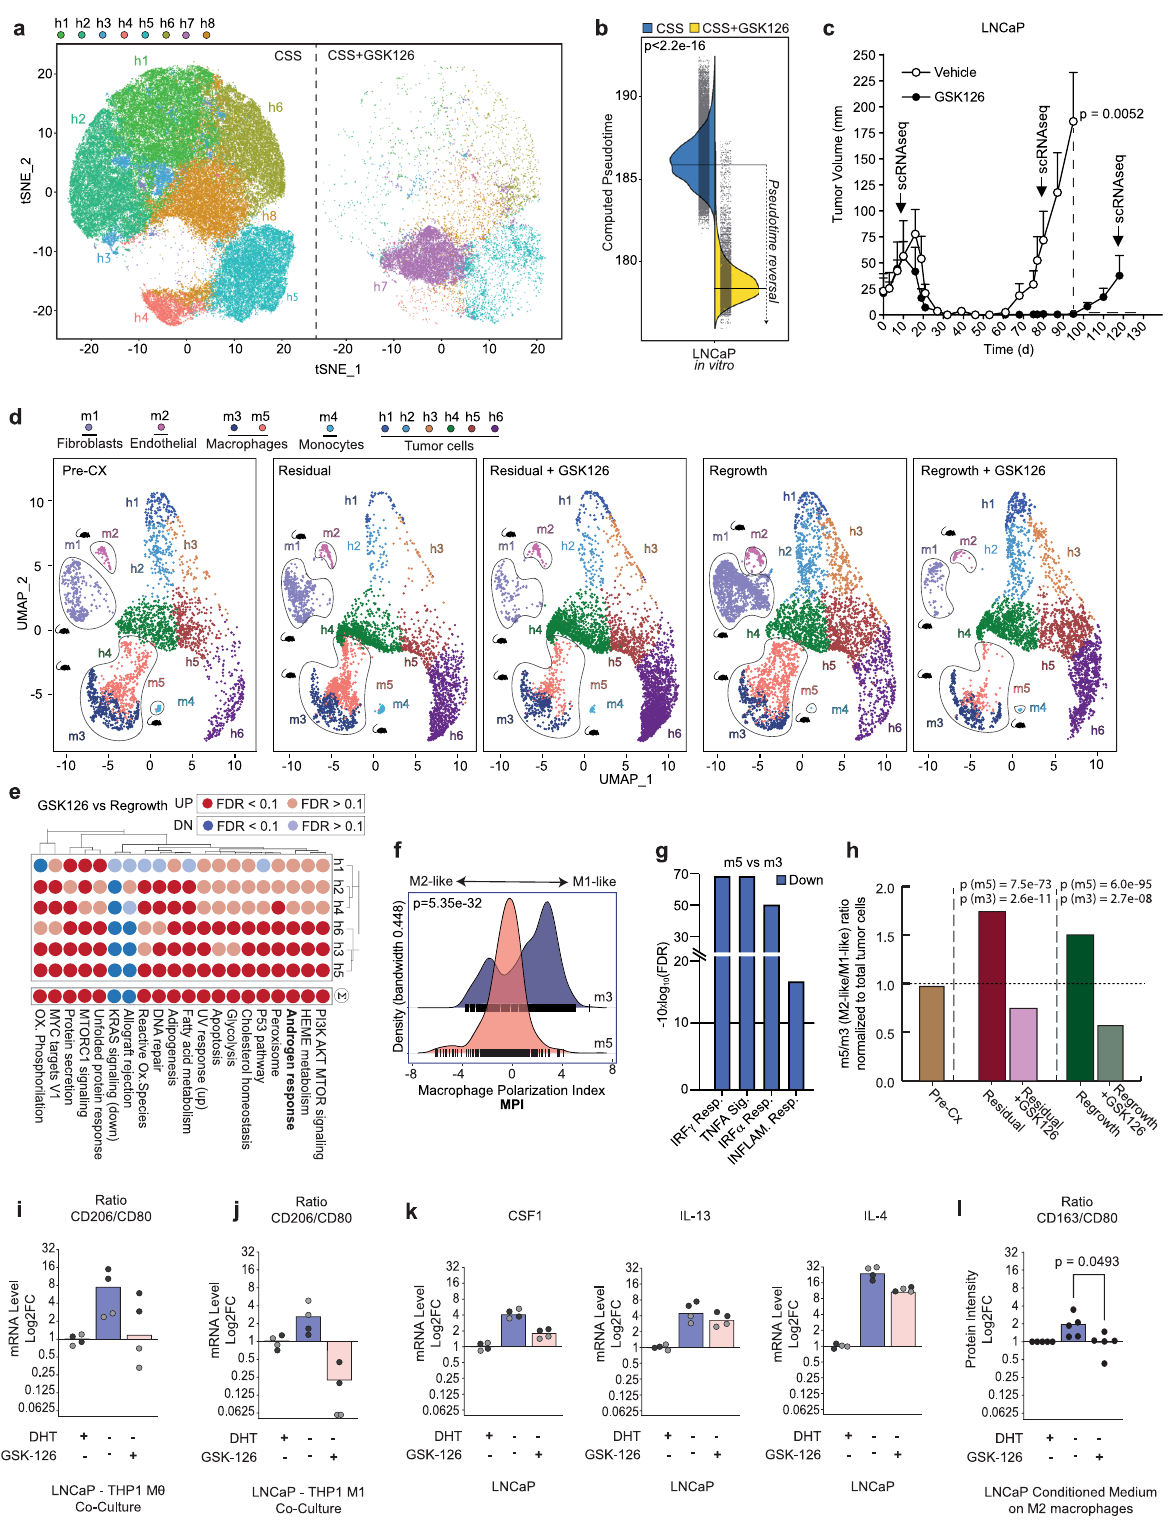
cytokine recently described to mediate castration resistance in pros- tate cancer 74 . Interestingly, correlating the IL23A expression with genomic features in our webtool identi fi es a tight association of IL23A expression with gains and ampli fi cation of its receptor IL23R . Such insights may be important for patient selection/strati fi cation for anti- IL23 targeting monoclonal antibodies under clinical develop- ment (i.e.,